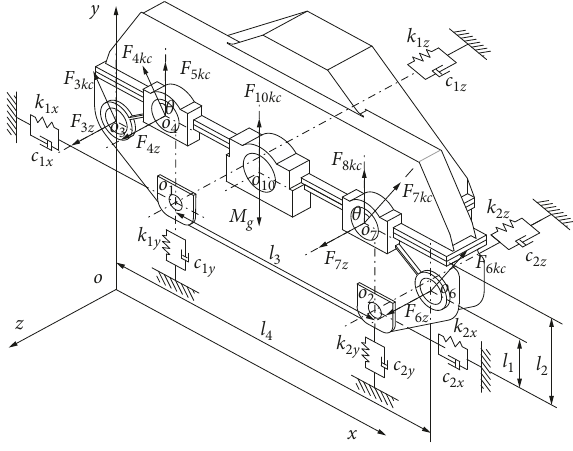
Figure 4: Dynamic model of reducer shell